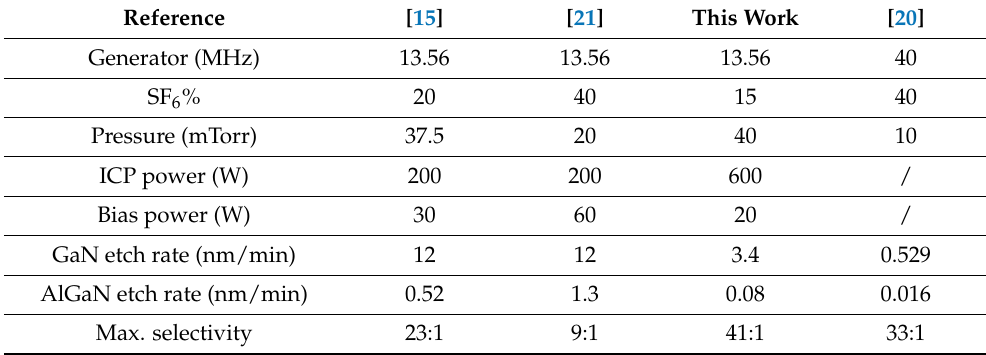
Table 1. Comparison of etch conditions, etch rates and selectivity among BCl 3 /SF 6 mixture selective etching recipes.